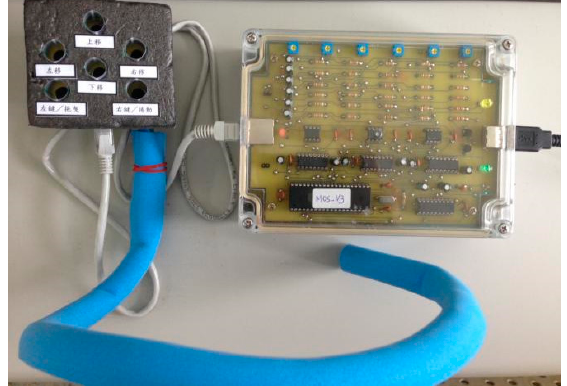
Figure 8. Image of the blowing-controlled mouse prototype.